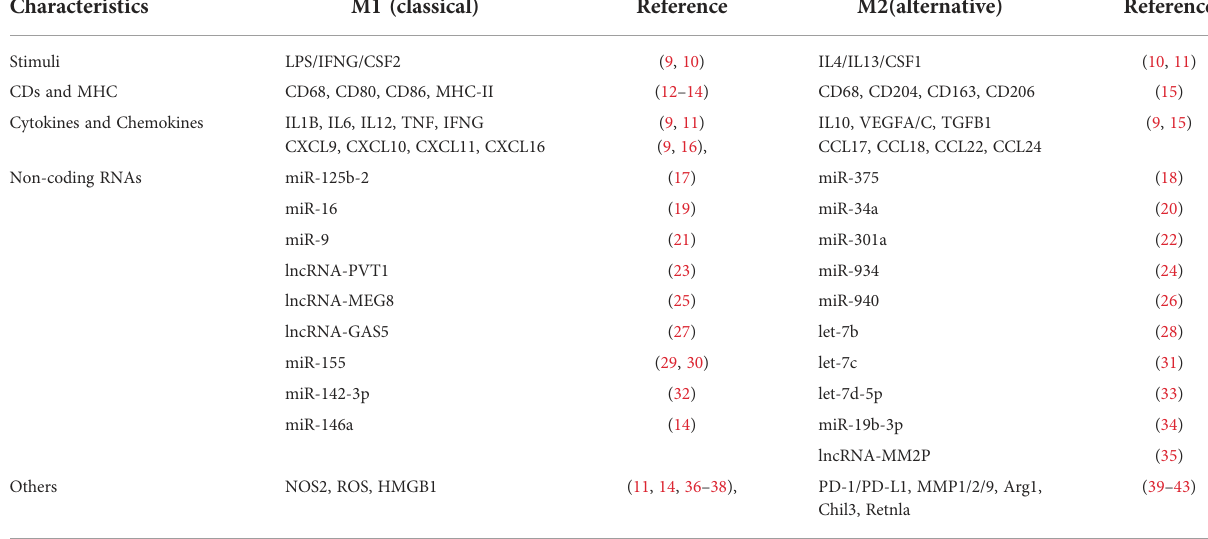
TABLE 1 M1 and M2 macrophages